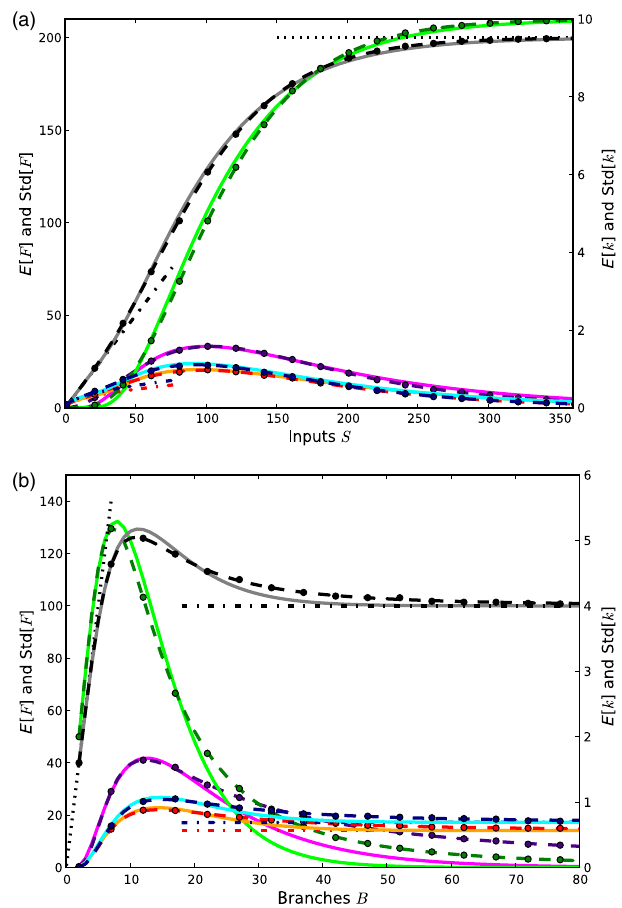
FIG. 2. Mean and standard deviation of the somatic input F , optimal number of branches. Results for (a) fixed B ¼ 10 and varying S and (b) vice versa, with S ¼ 100 . The remaining parameters are θ ¼ 10 , D ¼ 20 , and p 0 ¼ B − 1 , and P ð w Þ is Gaussian with mean E ½ w (cid:1) ¼ 1 and variance Var ½ w (cid:1) ¼ 2 . The effective somatic input E ½ F (cid:1) , the average number of nonlinear ffiffiffiffiffiffiffiffiffiffiffiffiffiffi branches E ½ k (cid:1) , and their standard deviations Std ½ F (cid:1) ¼ realizations of binomially and multinomially distributed synapses (circles). They agree well with the Gaussian approximation (solid lines) and the exact analytical solution (dashed lines). E ½ F (cid:1) are shown in black (exact solution, dashed lines) and gray (Gaussian approximation, solid lines); the lines that represent Std ½ F (cid:1) are colored blue and cyan for binomially distributed synapses and red and orange for multinomially distributed synapses. Lines that represent averages E ½ k (cid:1) are colored green and lime, and their variances Std ½ k (cid:1) for the binomial scenario are shown in purple and pink. Dash-dotted and dotted lines represent the linear and saturated limits, respectively. See the main text for a detailed